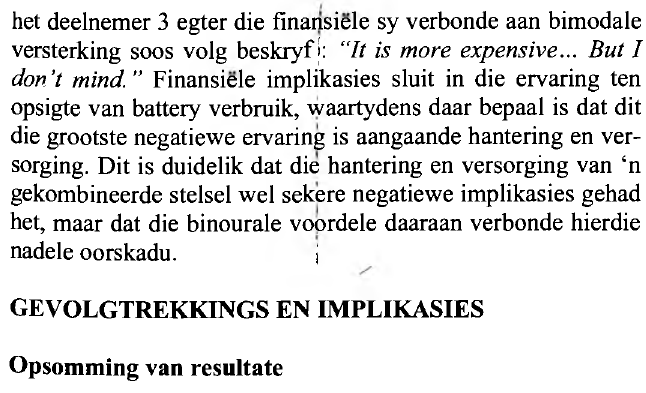
Figuur 4b: Deelnemers se ervarings aangaande die gebruik van bimodale versterking in terme van hantering en